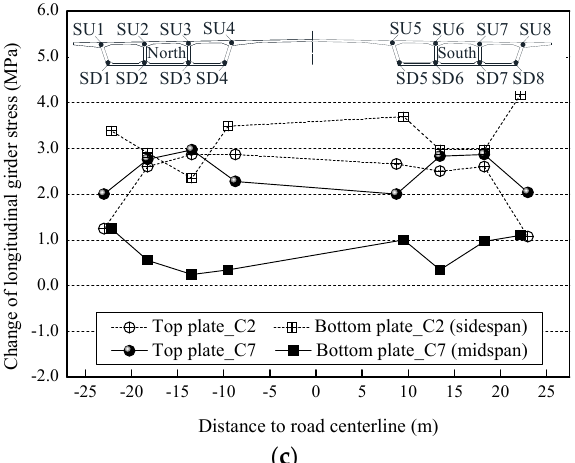
Figure 12. Measured changes of structural alignments and girder stresses caused by dual time-dependent effects (warming): ( a ) Cable alignment; ( b ) Girder alignment; and ( c ) Girder stress.